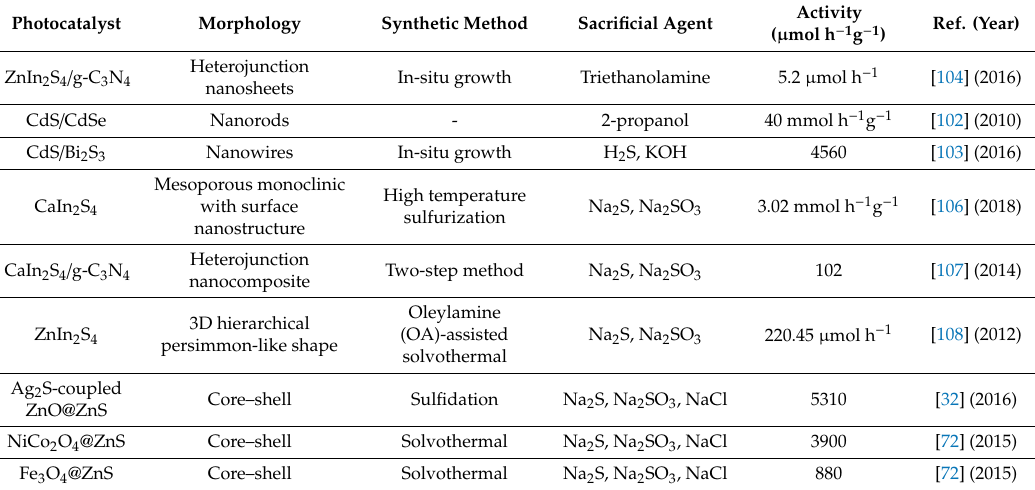
Table 11. Photocatalytic activity of photocatalysts with di ff erent